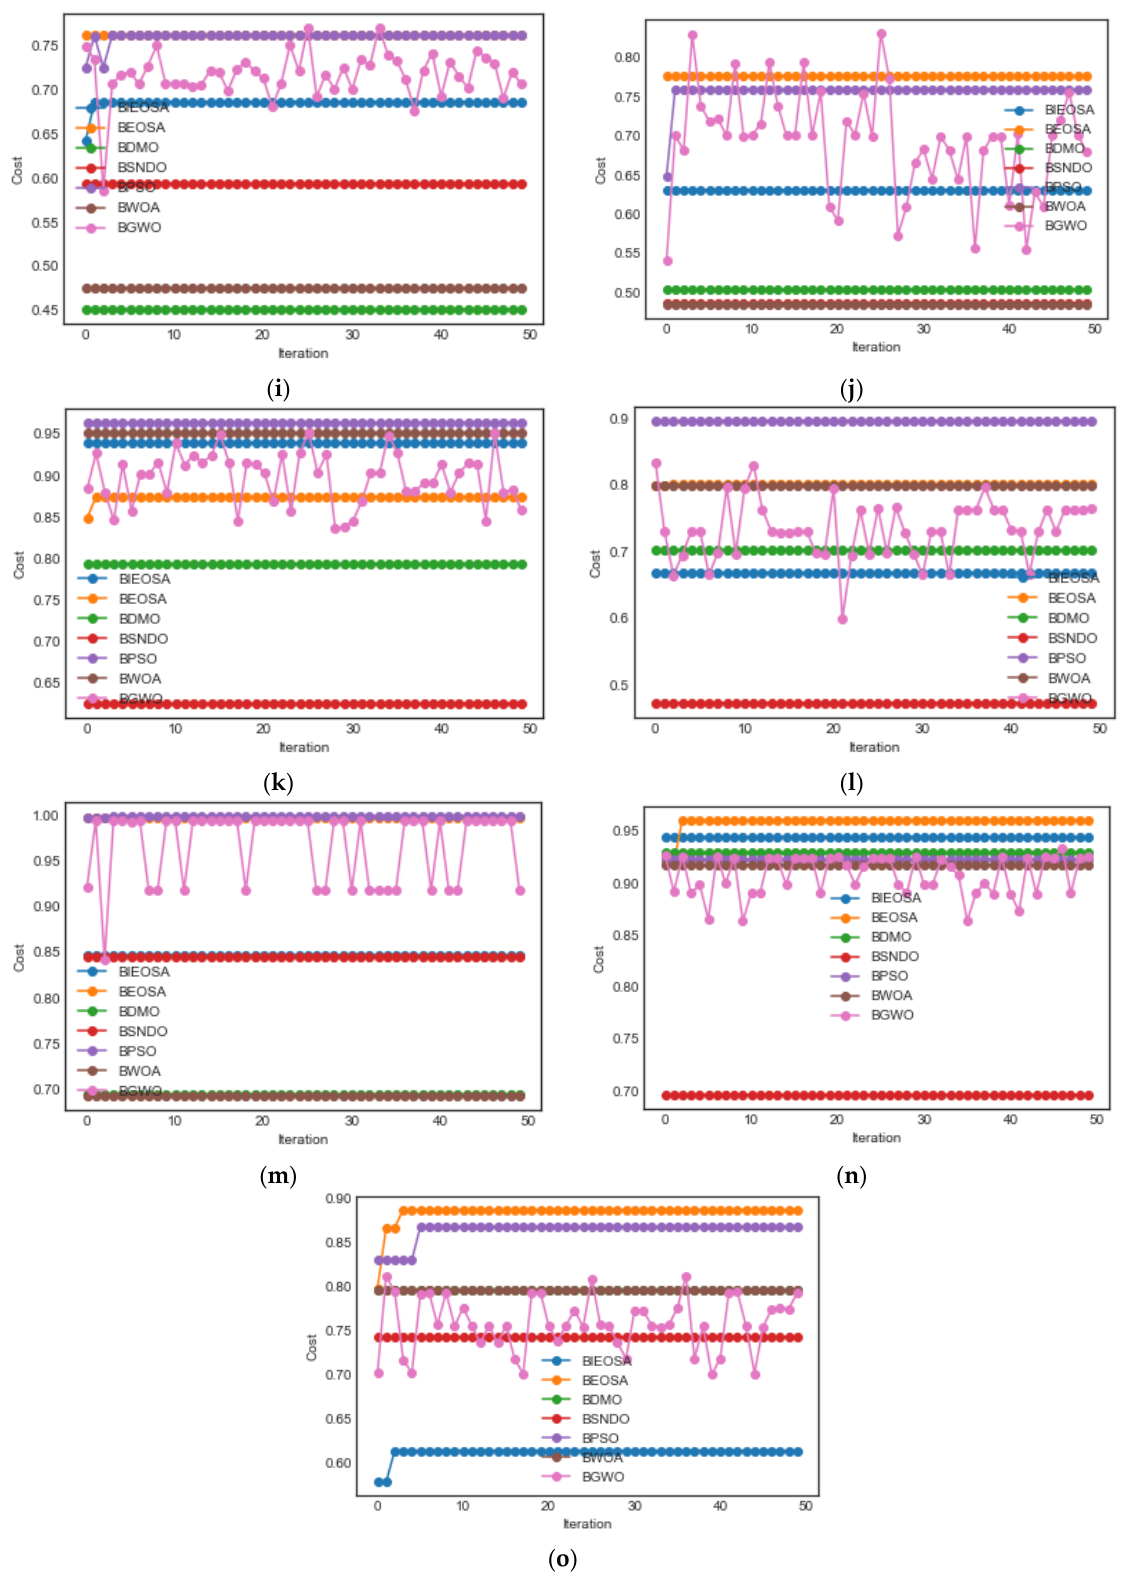
Figure 6. Graph-based comparative analysis of the cost function values obtained for all binary opti- mization methods on ( a ) Zoo; ( b ) Vote; ( c ) Wine; ( d ) Sonar; ( e ) Tic-tac-toe; ( f ) M-of-n; ( g ) Ionosphere; ( h ) Exactly; ( i ) Exactly2; ( j ) HeatEW; ( k ) CongressEW; ( l ) Lymphography; ( m ) Colon; ( n ) BreastEW; and ( o ) SpectEW datasets.